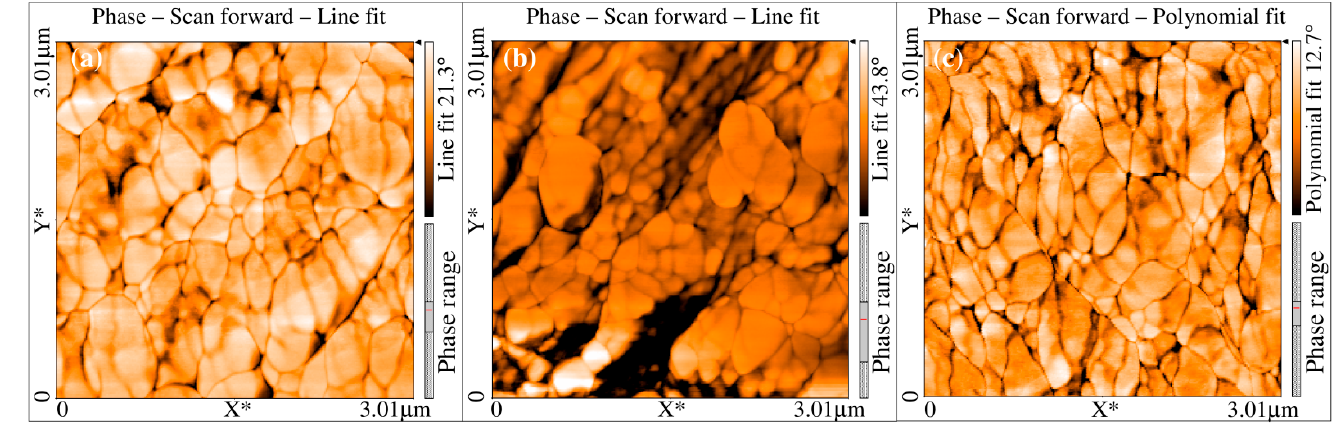
Figure 4. Micrographs of Ti samples showing surface grains of SMAT-modified samples treated for: ( a ) 15 min; ( b ) 20 min and ( c ) 25 min.